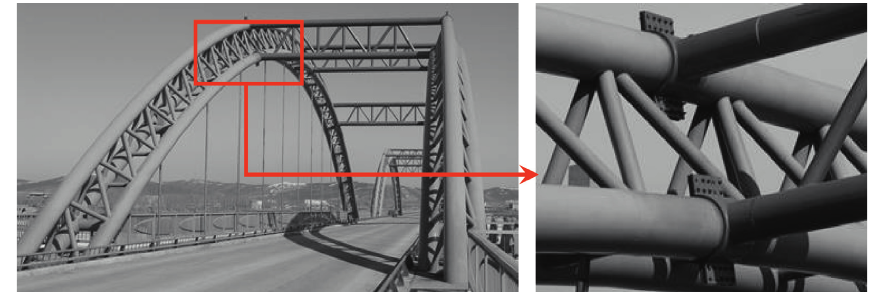
Figure 1: Photos of the bridge.